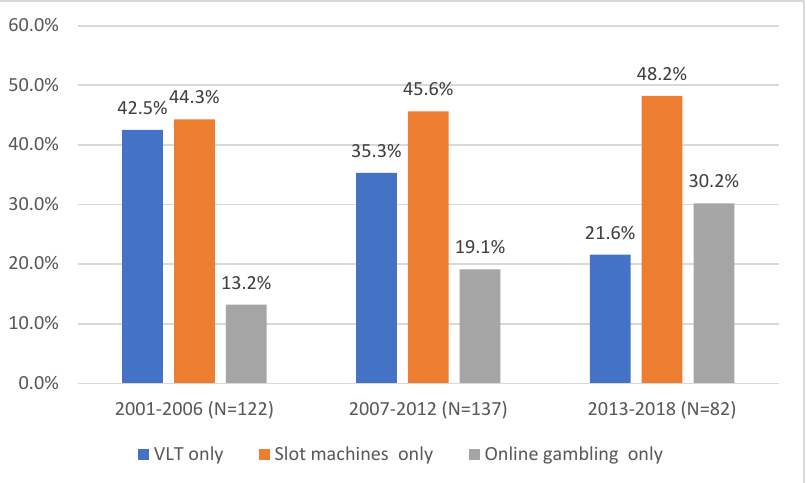
Figure 2. Evolution of referrals between 2001 and 2018 for problems relating to a single game-type ( n = 341).